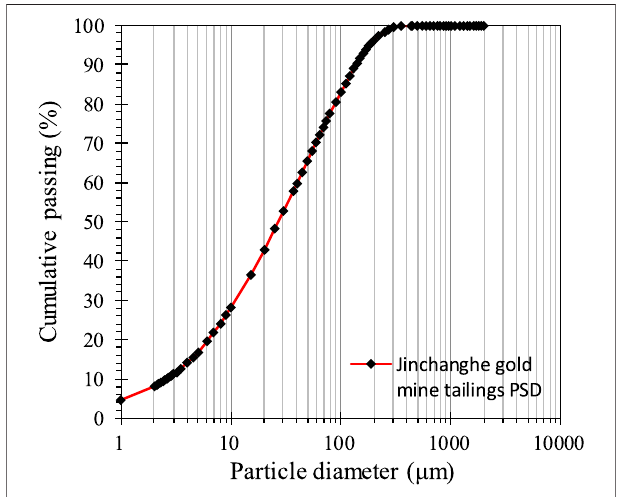
FIGURE 3 | Particle size distribution of tailings sourced from the Jinchanghe gold mine.